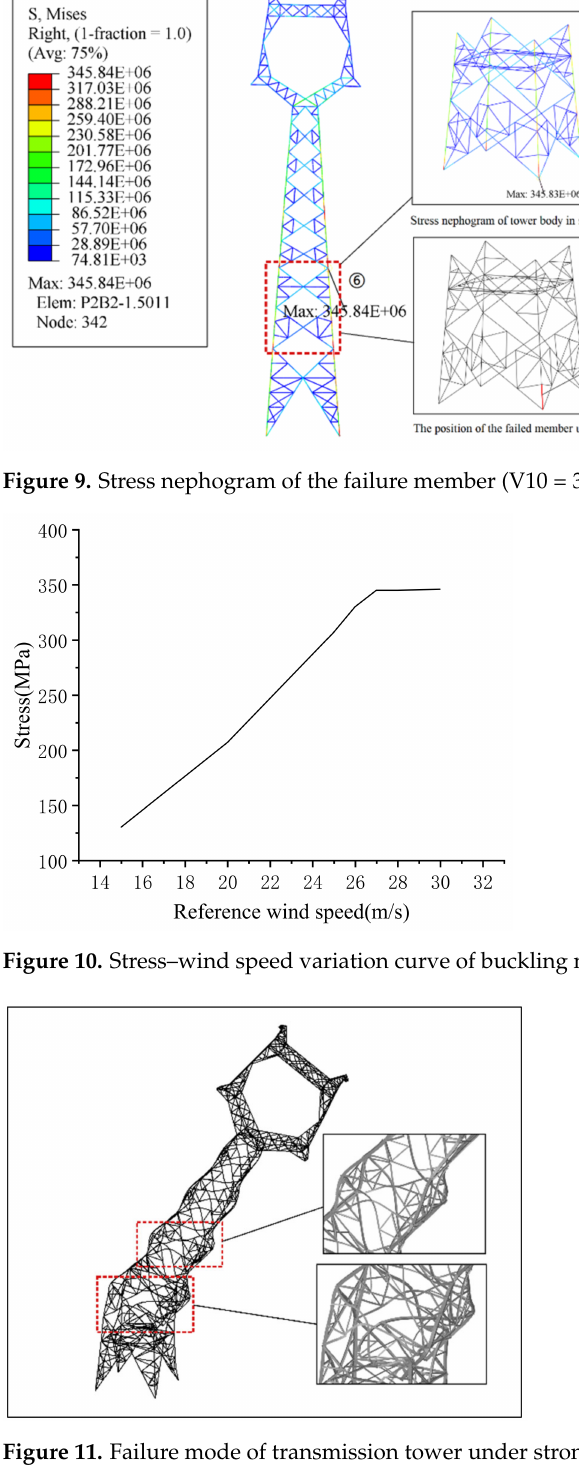
Figure 11. Failure mode of transmission tower under strong